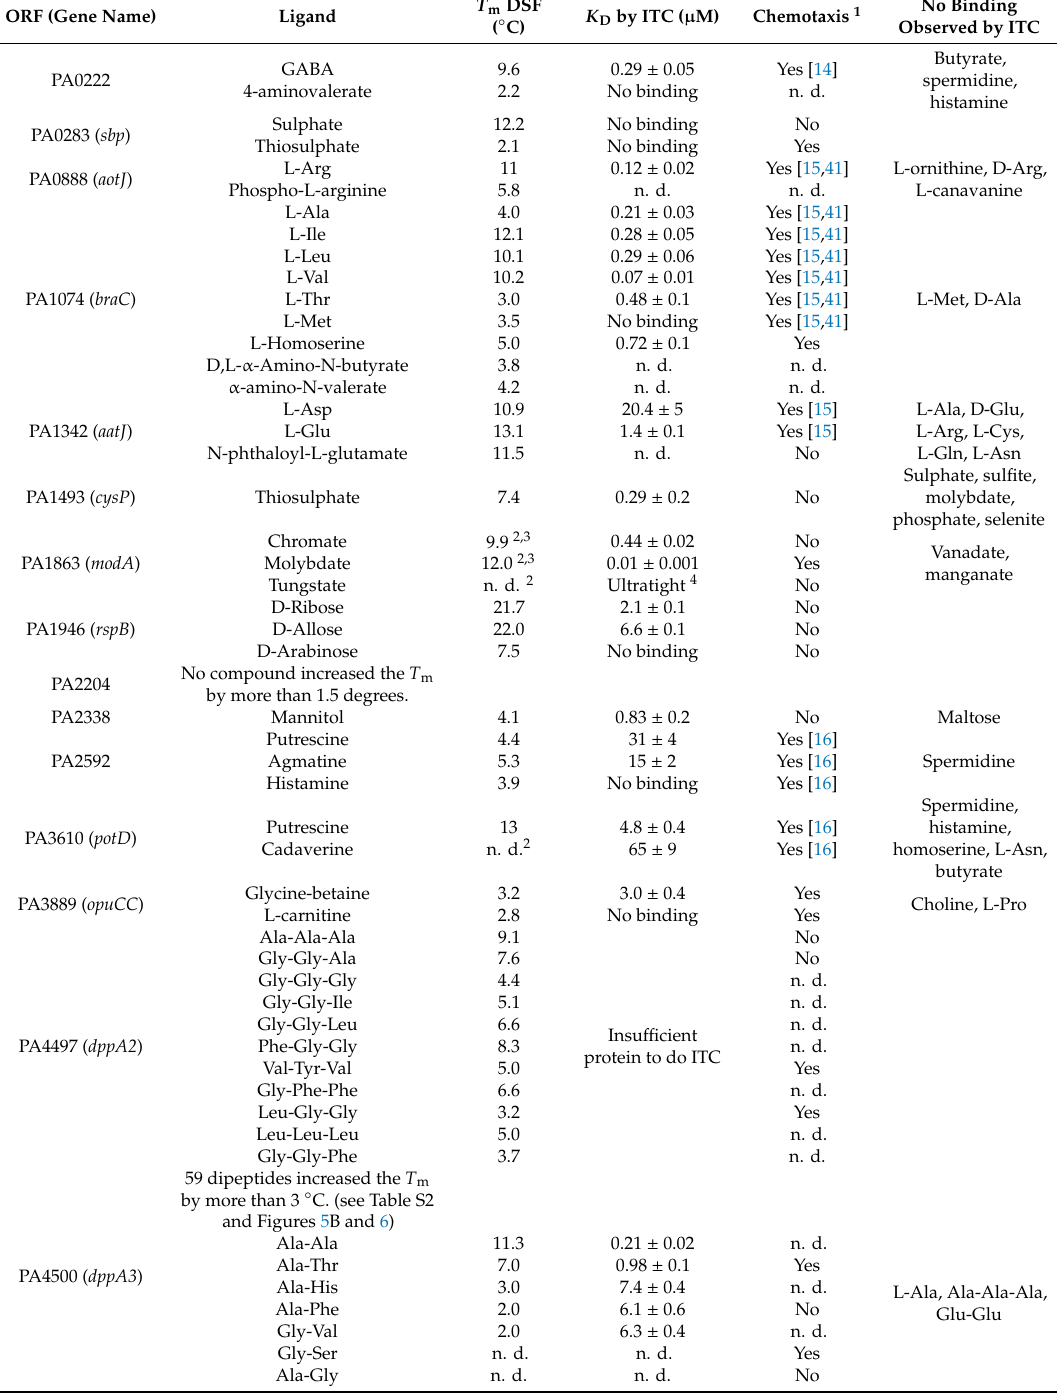
Table 1. Results from ligand binding studies to selected P. aeruginosa PAO1 Solute Binding Proteins. Shown are T m increases as determined by Di ff erential Scanning Fluorimetry (DSF) based thermal shift assays and dissociations constants ( K D ) derived from